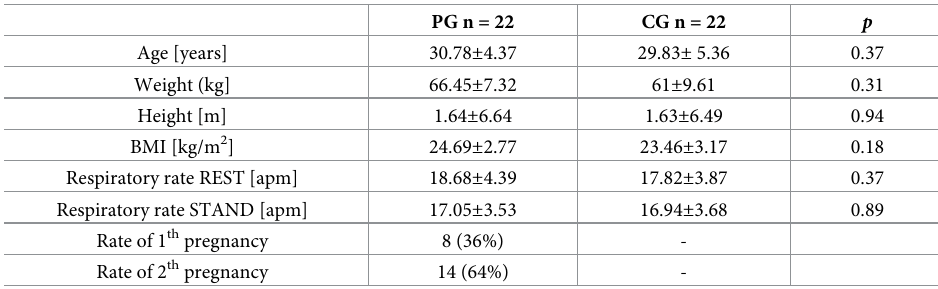
BMI: body mass index; REST: at rest at the left lateral decubitus; STAND: during active standing; apm: acts